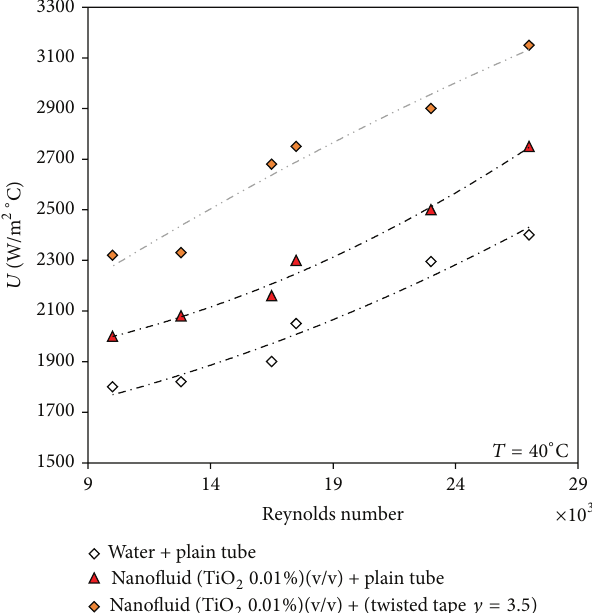
Figure8:VariationofoverallheattransfercoefficientwithReynolds